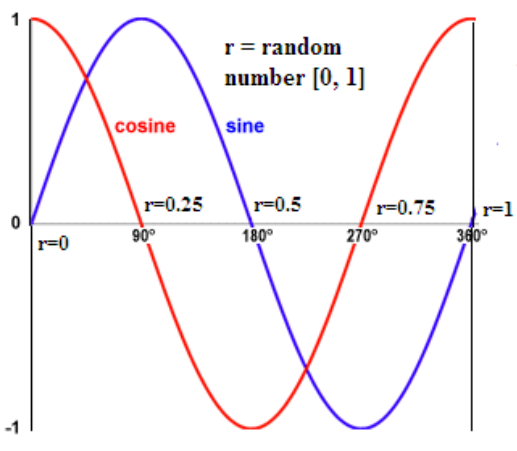
Fig. 2. Values of Sine (2 ∗ pi ∗ rand)) and Cosine (2 ∗ pi ∗ rand))